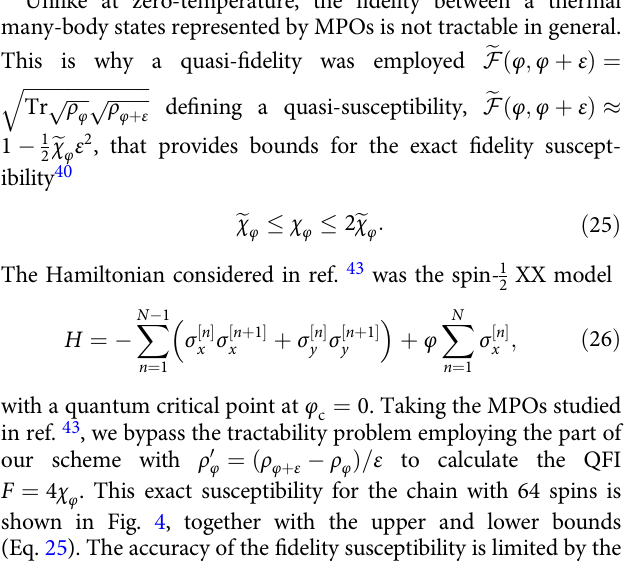
Unlike at zero-temperature, the fi delity between a thermal many-body states represented by MPOs is not tractable in general.